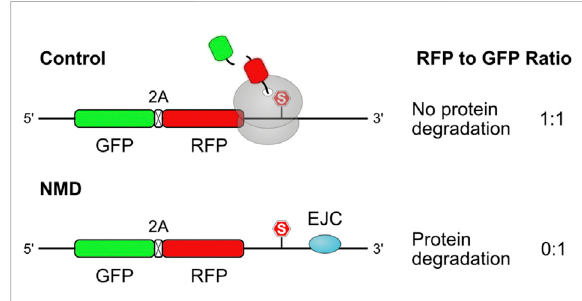
FIGURE 8 Dual fl uorescence reporter assay for measuring NMD- associated protein degradation. Two fl uorescent proteins, separated by a 2A peptide bond skipping sequence, are produced in equal amounts from the same mRNA. Introduction of an intron after the stop (S) codon results in deposition of an exon junction complex (EJC) in the 3 ′ UTR during splicing. The EJC downstream of the termination codon is perceived as a signal for NMD activation. When ribosomes reach the termination codon, the GFP protein has already been released, while RFP remains associated to the ribosome until termination is completed. NMD- induced co-translational degradation of the RFP protein results in decreased RFP to GFP ratios of the EJC-containing construct in fl ow cytometry analysis. As GFP serves as a normalizing factor for expression, changes in mRNA levels due to mRNA decay do not in fl uence the protein degradation